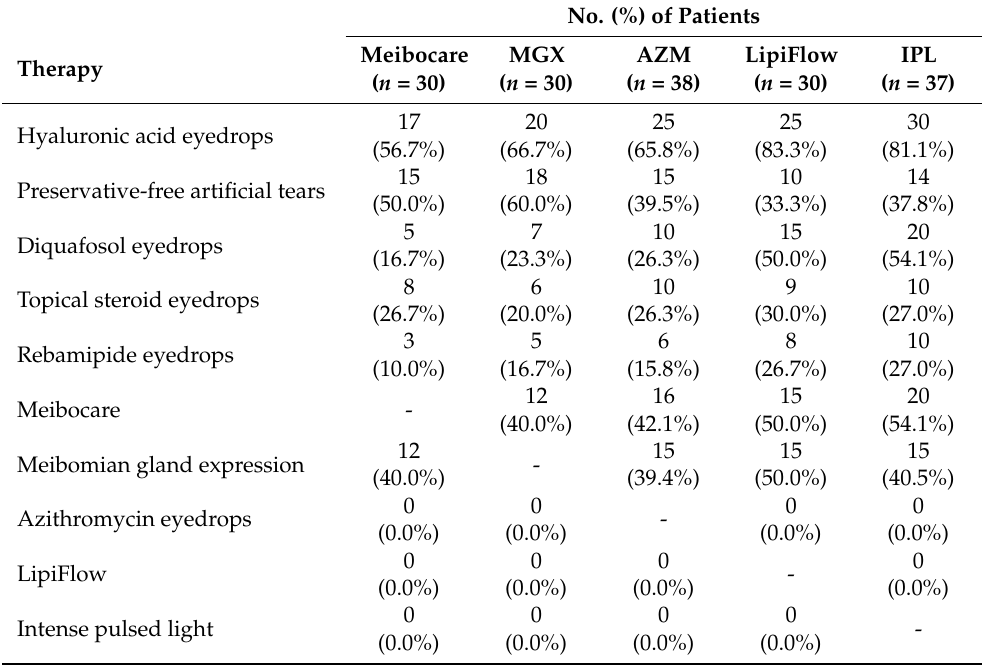
Table 3. Previous therapies for the study patients with meibomian gland dysfunction in the meibocare, meibomian gland expression (MGX), azithromycin eyedrop (AZM), LipiFlow, and intense pulsed light (IPL)